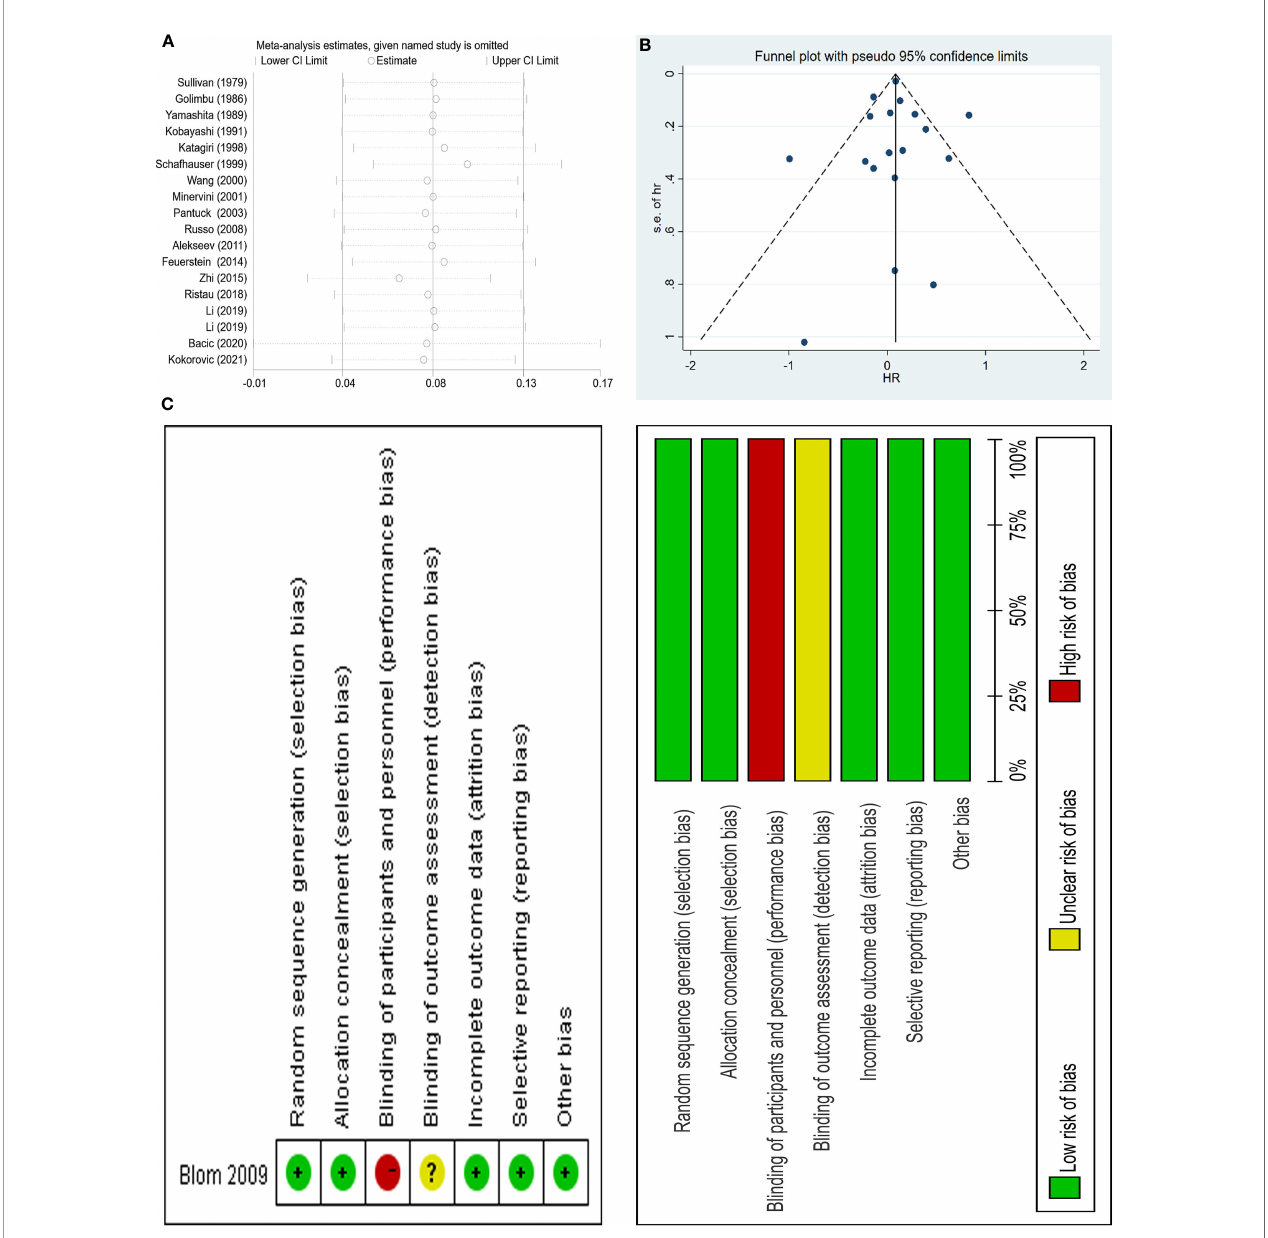
FIGURE 3 | Sensitivity analysis and funnel plot of the meta-analysis OS as well as risk of bias summary of included trial; (A) sensitivity analysis; (B) funnel plot; (C) risk of bias summary of included